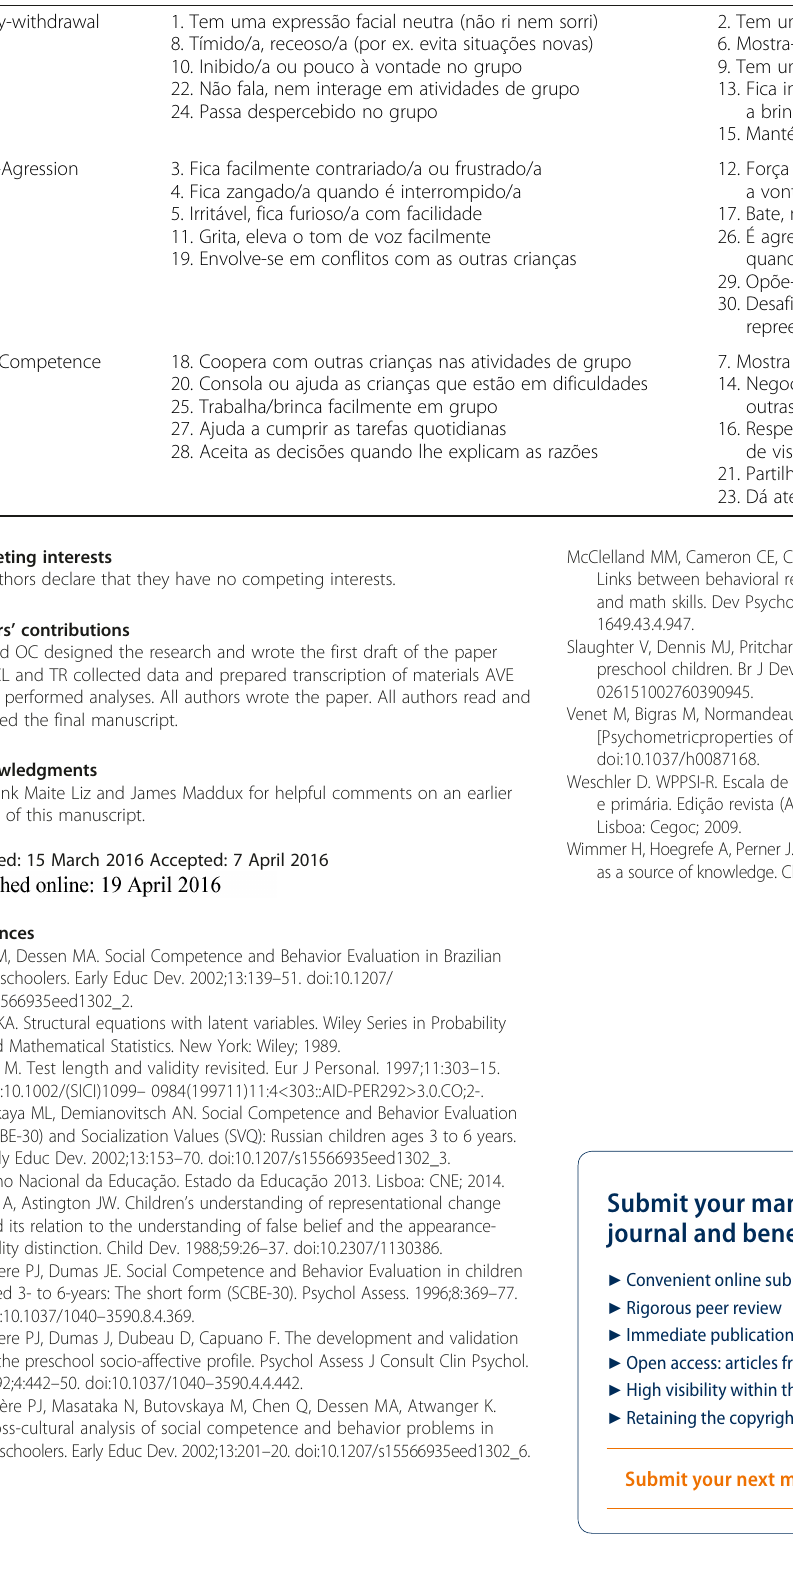
Table 5 Items included and excluded from the SCBE 15-item solution